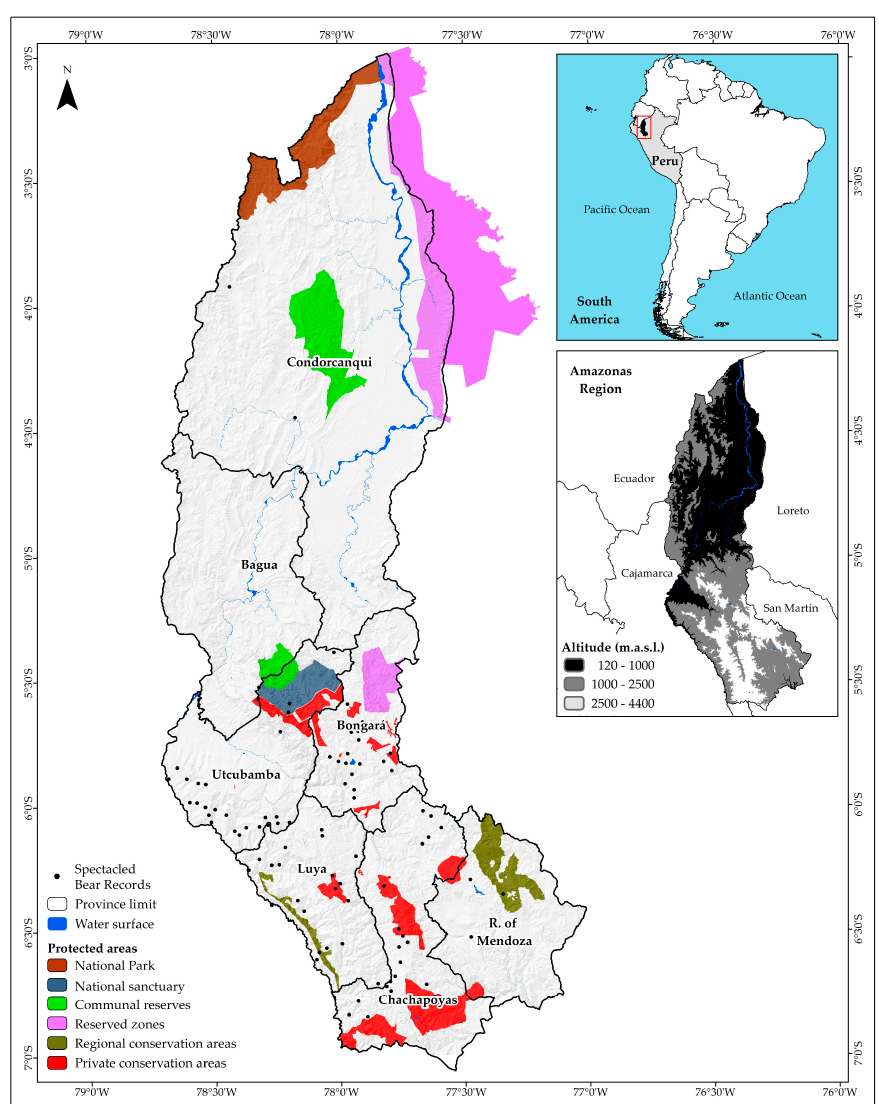
Figure 1. Geographical location and protected areas in Amazonia